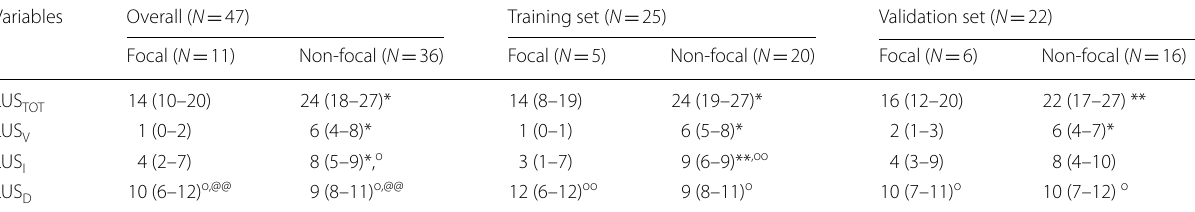
Abbreviations: LUS TOT : lung ultrasound score total; LUS V : lung ultrasound score ventral region; LUS I lung ultrasound score intermediate region; LUS D lung ultrasound score dorsal